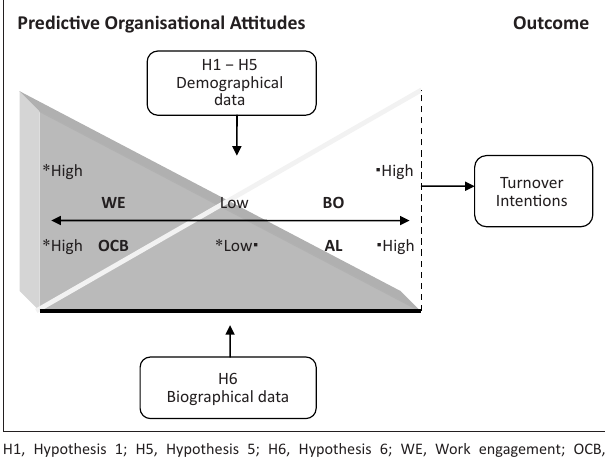
FIGURE 1: Research model of the predictive relationships with turnover